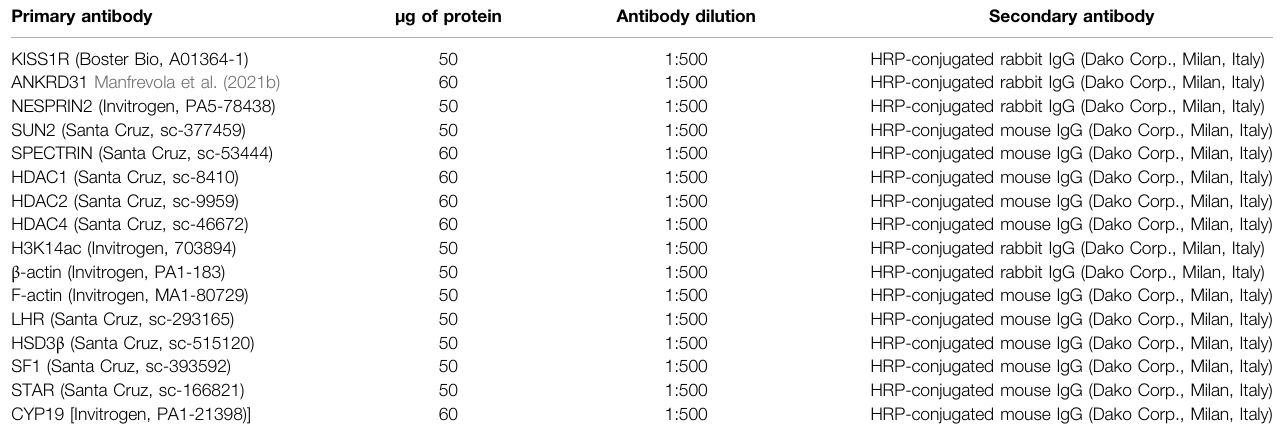
TABLE 2 | Primary antibodies, protein amounts, antibody dilution, and secondary antibodies used for Western blot analysis. Primary antibody µg of protein Antibody dilution Secondary